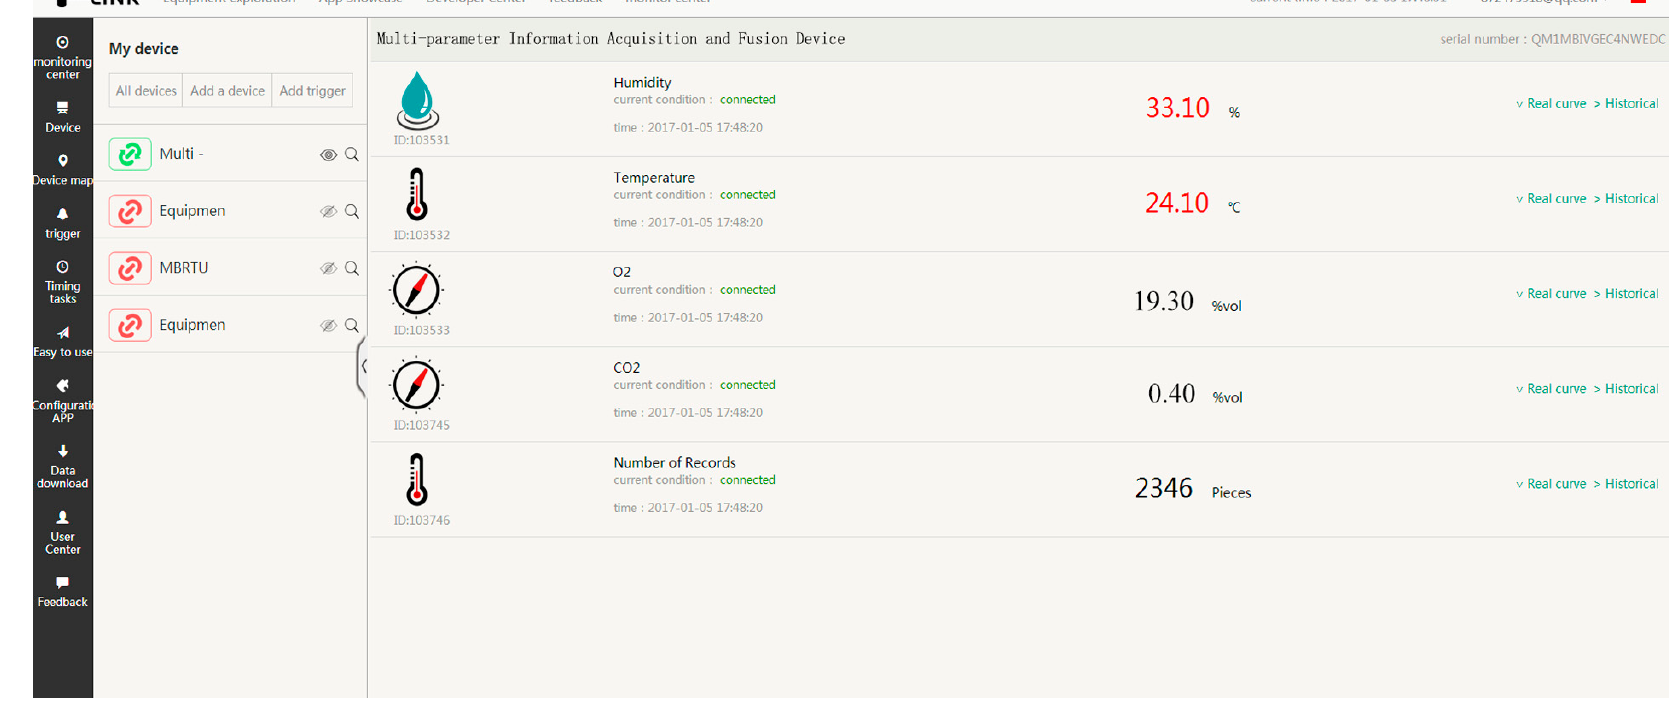
Figure 11. The PC version software interface.